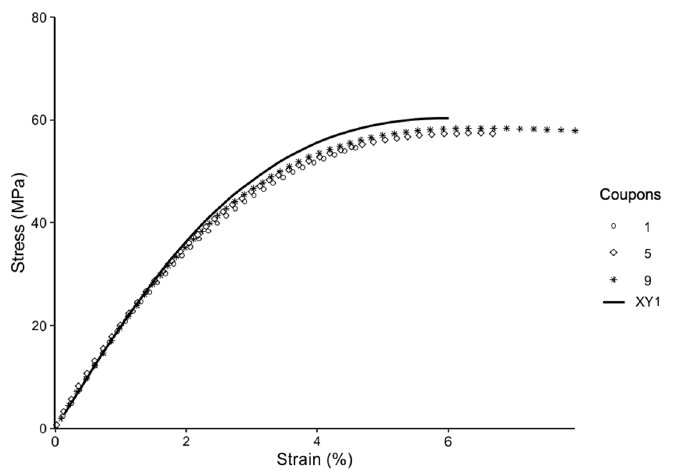
Figure 8. Stress–Strain curve for coupons printed in XY, annealed (1,5,9), and control (XY1).